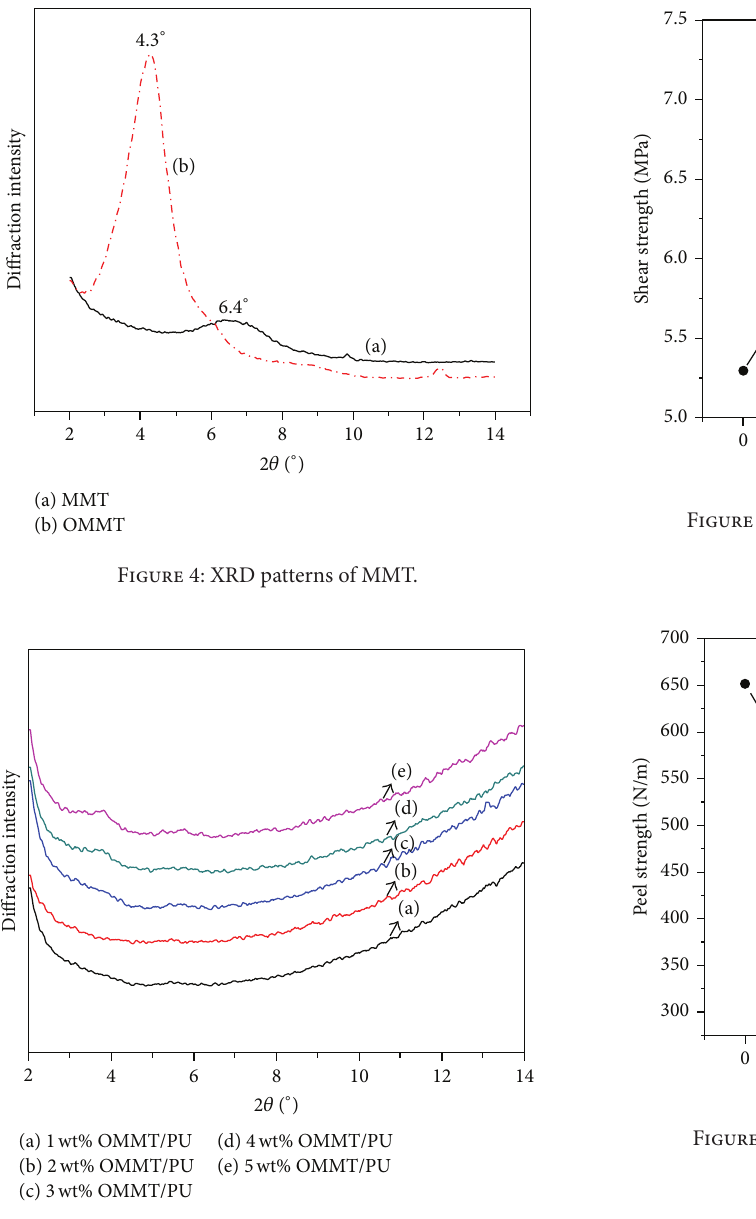
Figure 5: XRD patterns of OMMT/PU.